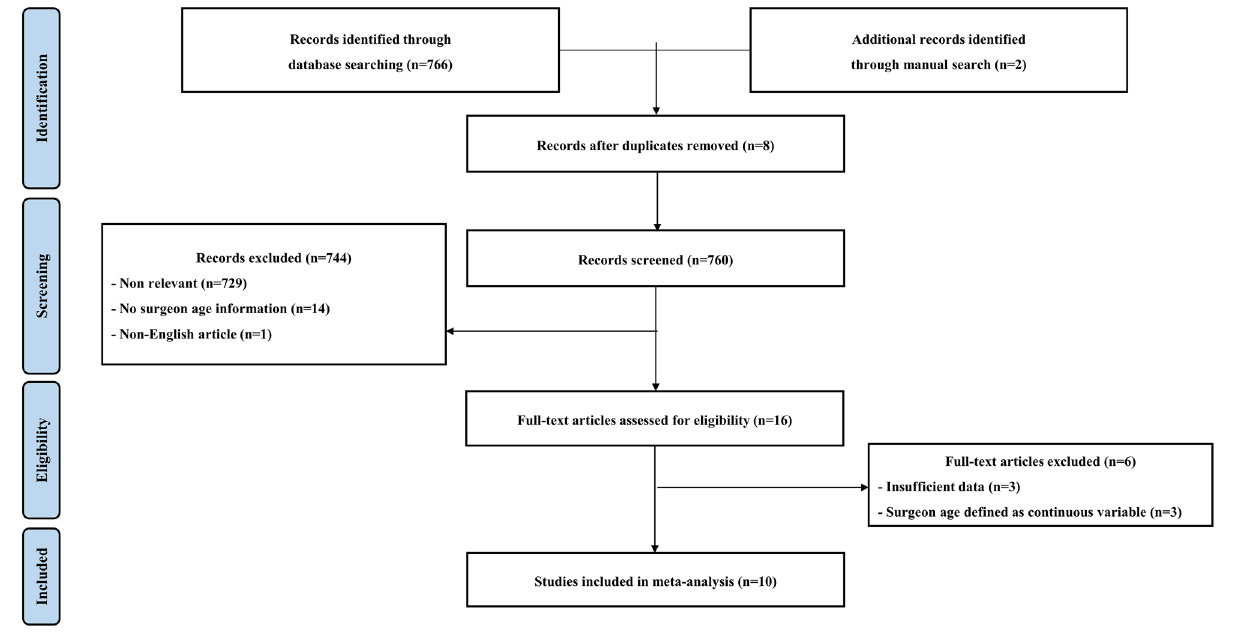
Figure 1. The PRISMA flow